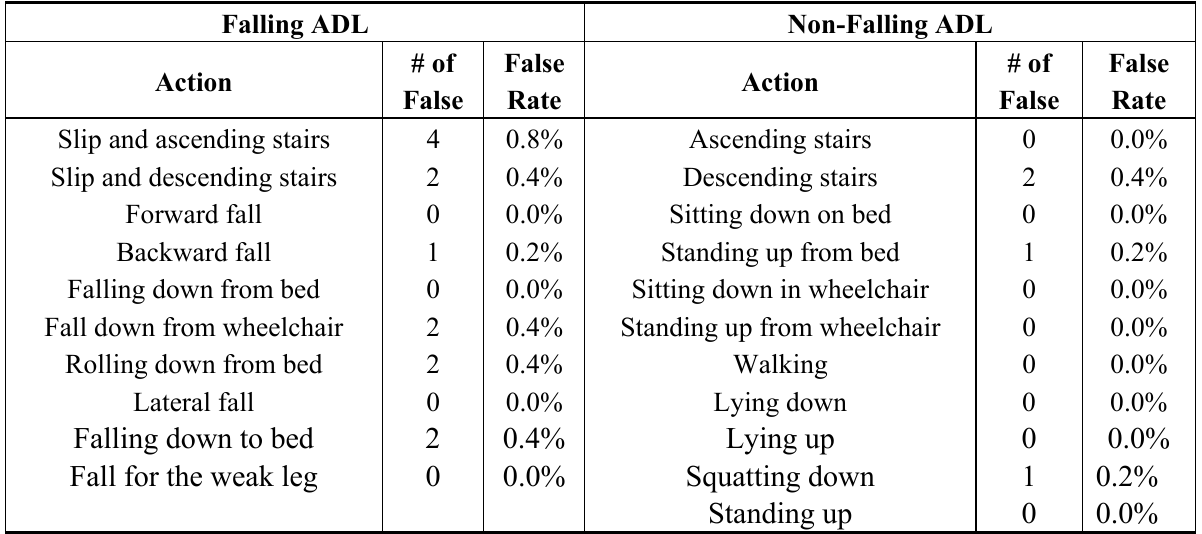
Table 5. The frequency of the false classification of each